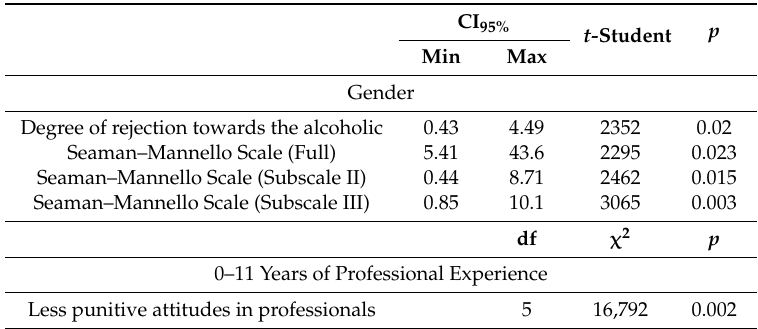
Table 4. Relationship between demographic data and the Seaman–Mannello